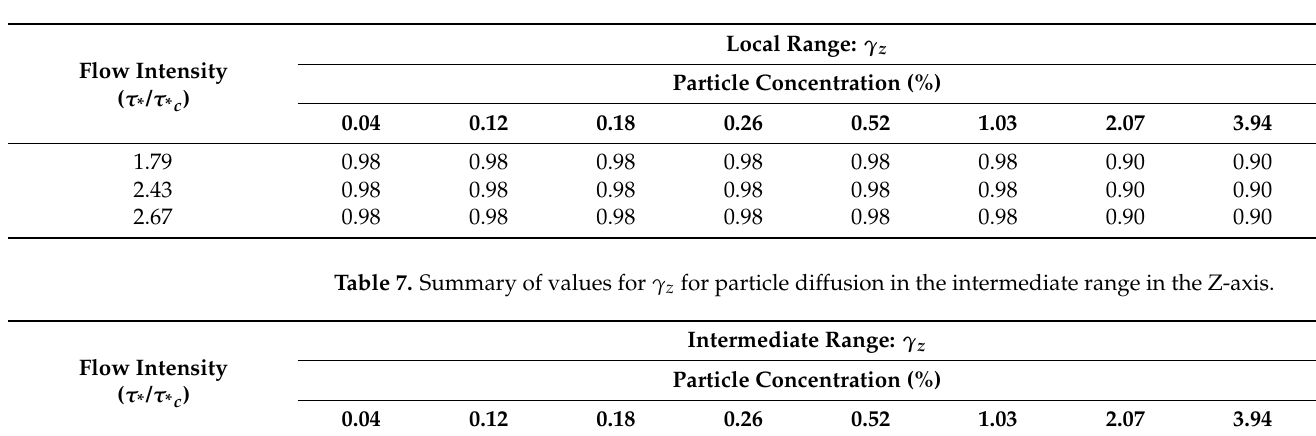
Table 6. Summary of values for γ z for particle diffusion in the local range in the Z-axis.